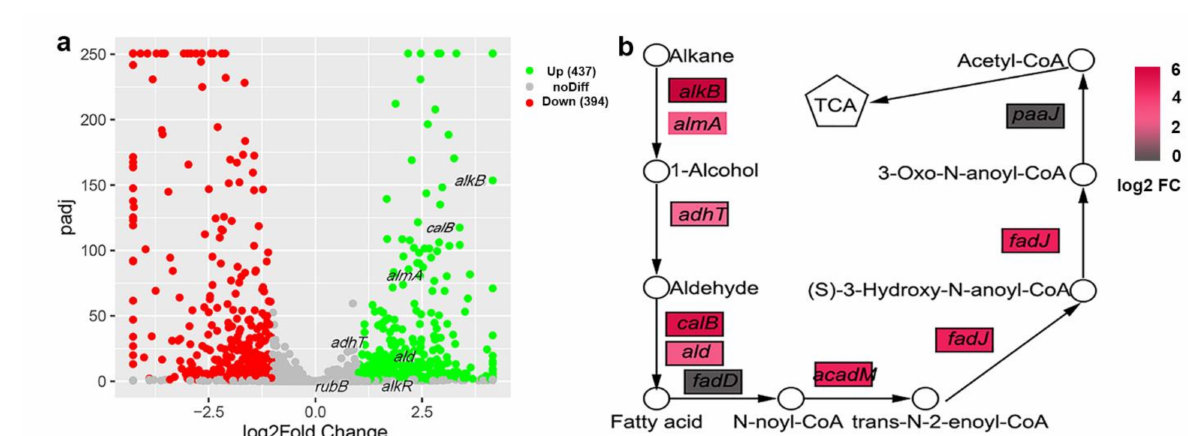
Figure 4. ( a ) The volcano plot illustrating the expression levels of the genes with significant difference in alkane degra- dation. Several genes involved in alkane metabolism were labeled. alkB , alkane hydroxylase gene; alma , flavin-binding monooxygenase gene; adhT , alcohol dehydrogenase gene; ald , aldehyde dehydrogenase gene; alkR , alkane hydroxylase tran- scriptional regulator gene; rub , rubredoxin reductase gene. ( b ) Pathway of alkane metabolism and related genes involved in alkane oxidation and β -oxidation. calB , aldehyde dehydrogenase gene; fadD , acyl-CoA synthetase gene; acadM , enoyl-CoA hydratase gene; fadJ , 3-hydroxybutyryl-CoA epimerase gene; paaJ , beta-ketoadipyl CoA thiolase gene. Upregulated genes are marked in red, and the non-induced genes are indicated in gray. A deeper color used in the illustration represents stronger induction by C 20